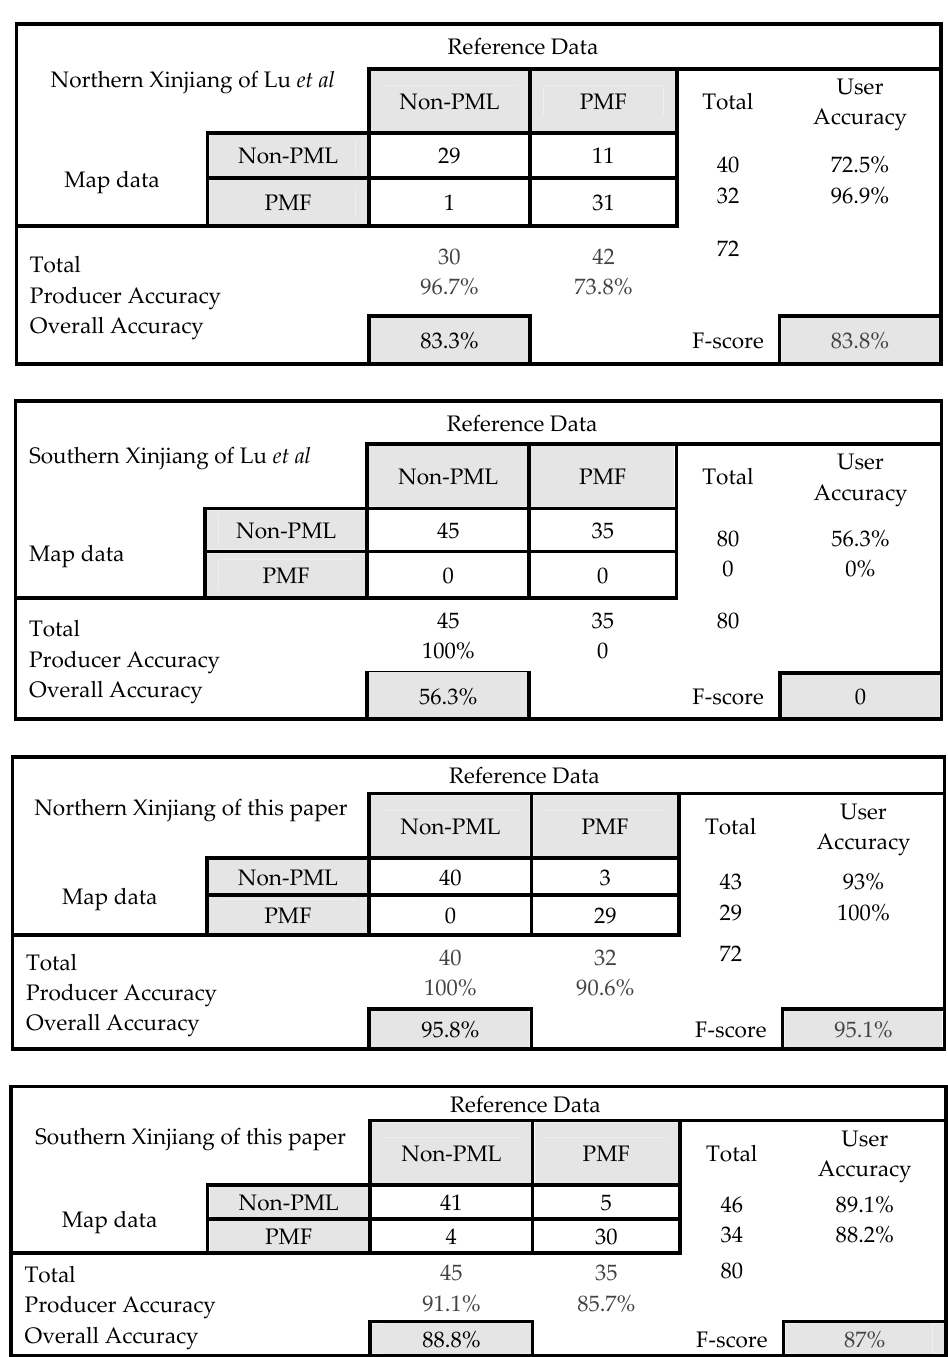
Remote Sens. 2019 , 11 , x FOR PEER REVIEW 21 of 27 Table 9. Confusion matrix for the di ff erent algorithms in each zone using Landsat-5 TM images in 2011. Table 9. Confusion matrix for the different algorithms in each zone using Landsat-5 TM images in 2011.